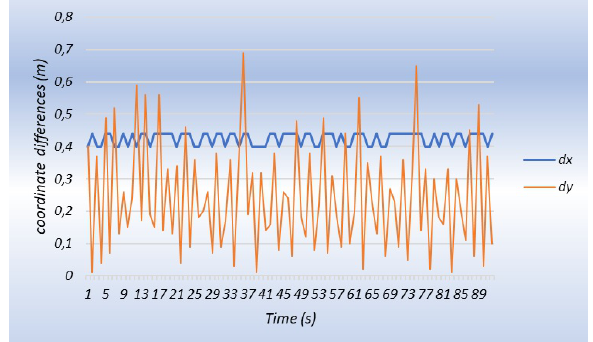
Figure 3: Positioning